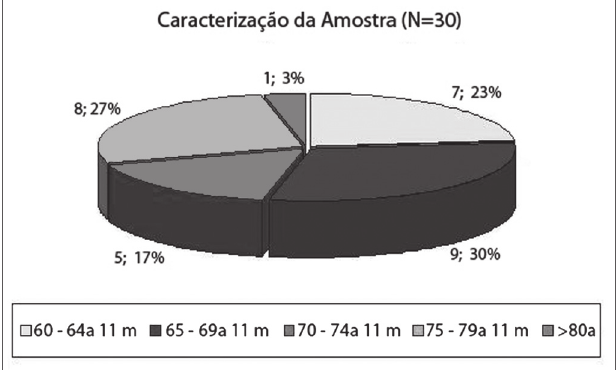
Figura 2. Caracterização da Amostra do Estudo (N=30) - N: